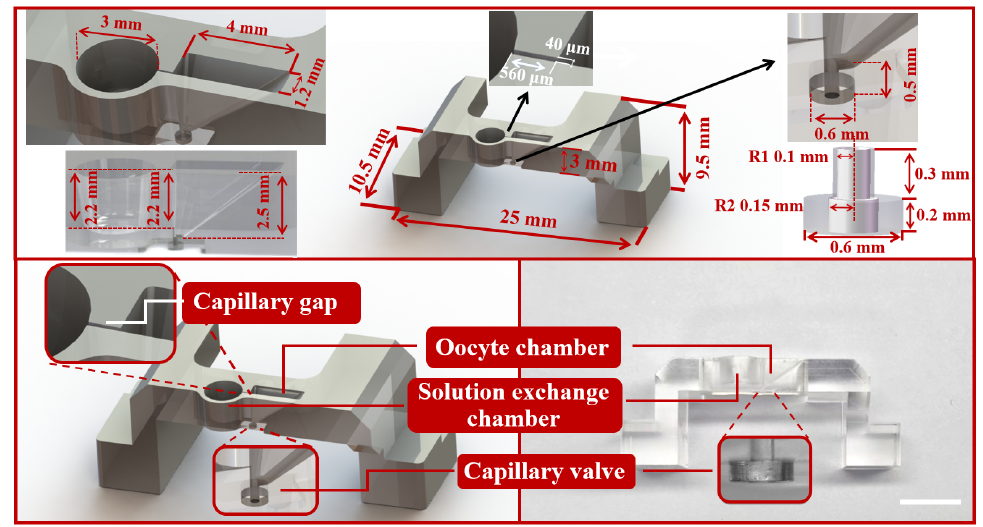
Figure 3. The dimension detail, structure diagram and physical diagram of the open microfluidic chip, composed of capillary gap, oocyte chamber, solution exchange chamber and capillary valve. Scale bars are 2